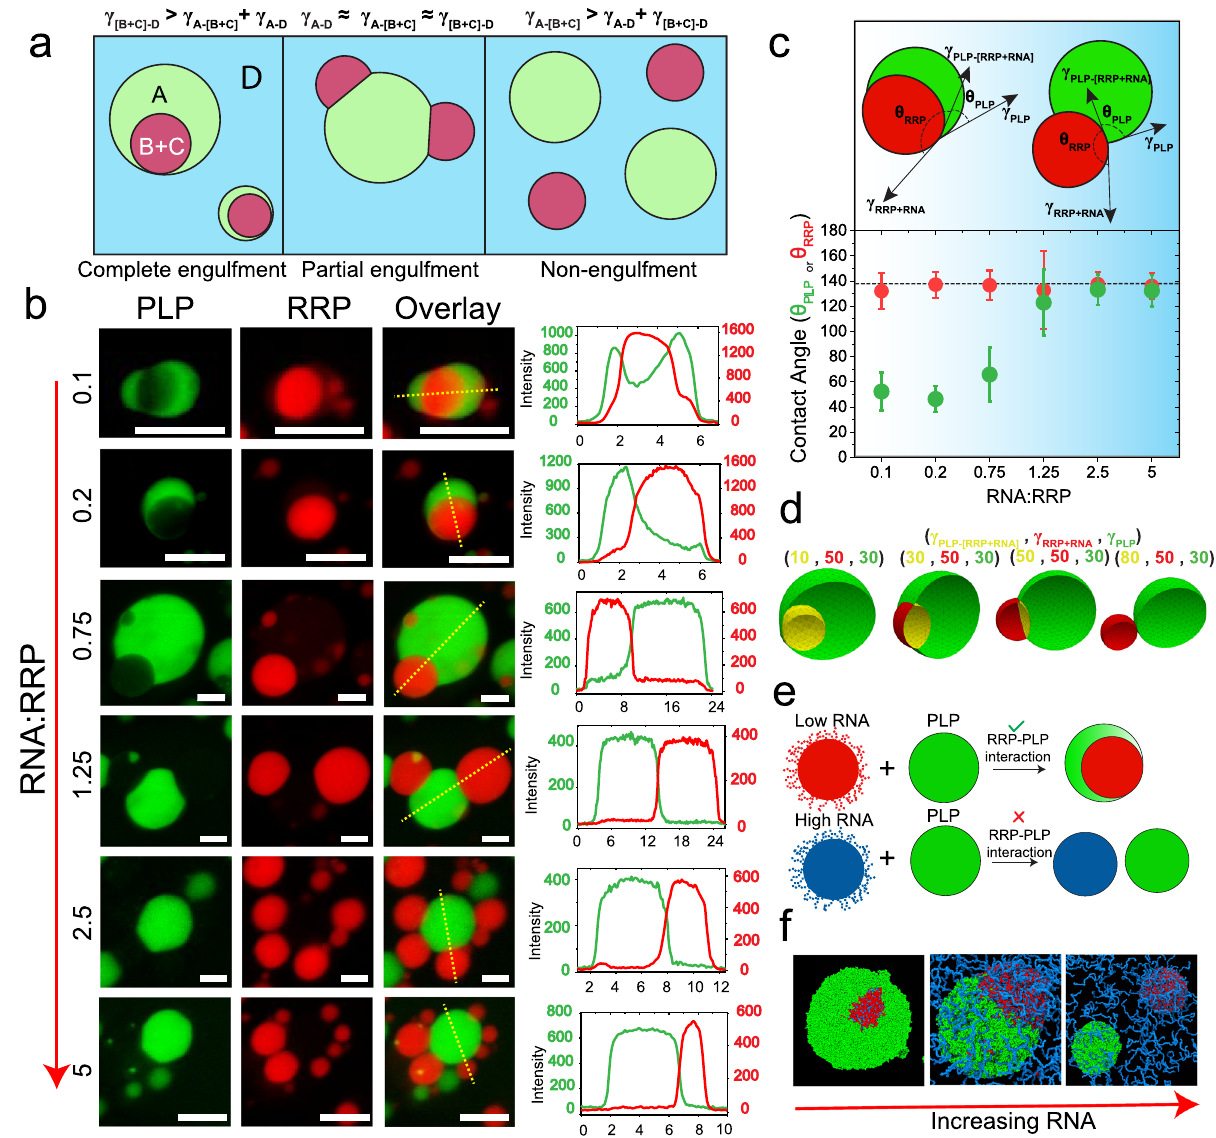
Fig. 4 RNA-to-RRP ratio tunes the morphology of coexisting condensates. a A schematic diagram showing that the relative ranking of interfacial tensions dictates the morphology of the biphasic condensates (A-droplet, B + C-droplet, D-dispersed phase). b Fluorescence microscopy images and intensity pro fi les for coexisting homotypic PLP droplets (green) and heterotypic RRP-RNA condensates (red) at different RNA-to-RRP ratios. Each type of droplet was separately prepared at initial concentrations of [PLP] = 400 µ M, [RGRGG] 5 = 4.0 mg/ml and variable poly(rU) RNA-to-RRP ratios (wt/wt), as indicated and then mixed (1:1 vol/vol). All samples were prepared in 25 mM Tris-HCl, 150 mM NaCl, and 20 mM DTT buffer. All Scale bars represent 5 µ m. c Contact angle plot (bottom) for coexisting PLP ( θ PLP in green) and RRP-RNA ( θ RRP in red) condensates for all the samples shown in ( b ) ( n = 25 droplets per sample). The dashed line represents the average value of θ RRP across all samples. Data are presented as mean values ±1 s.d. (top) A schematic showing the coexisting condensates ’ morphology at low and high θ PLP . Color gradient (blue) represents the increasing RNA concentration. Source data are provided as a Source Data fi le. d Coexistence patterns of a model doublet-of-droplet as a function of interfacial tensions calculated using a fl uid interfacial modeling tool (Surface Evolver 71 ). e Proposed mechanism of RNA-mediated fl uid- fl uid interface regulation. At low RNA concentration, RNA-RRP condensates (red) are enriched with RRP chains on their surfaces, thus facilitating RRP-PLP interfacial binding and mediating a wetting behavior. At high RNA concentration, RRP-RNA condensate surfaces (blue) are enriched with RNA chains, limiting the available RRP molecules for PLP binding, which is responsible for minimal wetting behavior with PLP condensates (green). f Equilibrium MD snapshots at variable RNA-to-RRP mixing ratios (see Fig. S22b for the corresponding density pro fi les). (RRP = FUS RGG3 , red; RNA = poly(rU), blue; PLP = FUS PLP , green). C RRP = 5.6 mg/ml, RNA-to-RRP ratio = 0.3, 1.8, 3.2 (respectively for the three snapshots shown), C PLP = 7.22